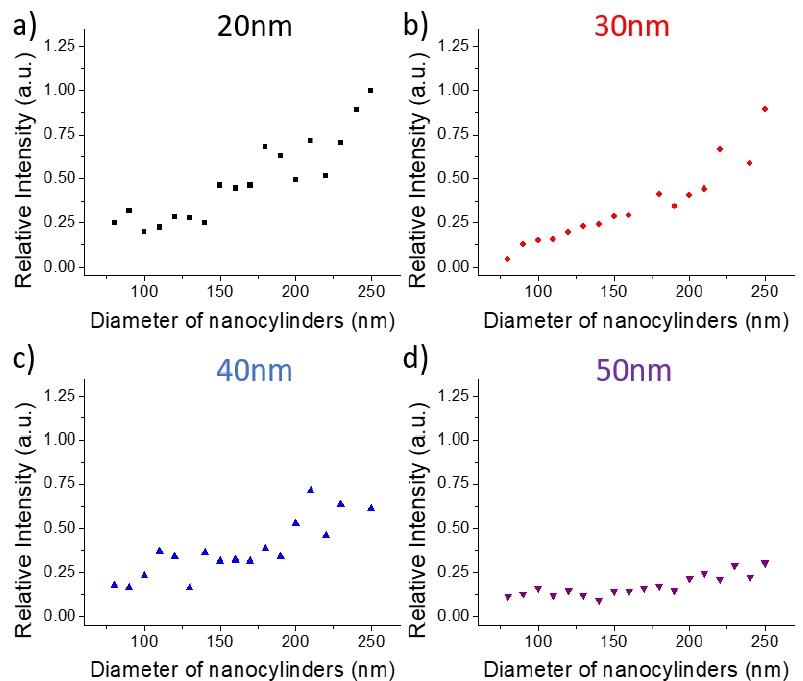
Figure 3. Evolution of the SERS intensities of the band located at 1580 cm − 1 depending on the nanocylinder diameter and for the four film thicknesses: ( a ) 20, ( b ) 30, ( c ) 40, and ( d ) 50 nm. Excitation wavelength: 638 nm. Points size includes the error bars.